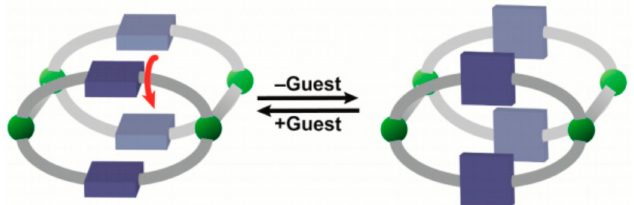
Figure 14. Ligands can rotate to open and close the pore, upon adsorption and desorption respectively. Green spheres represent metal centers or secondary building units (SBUs), gray represents rigid portions of the ligand, and blue components represent flexible portions of the ligand